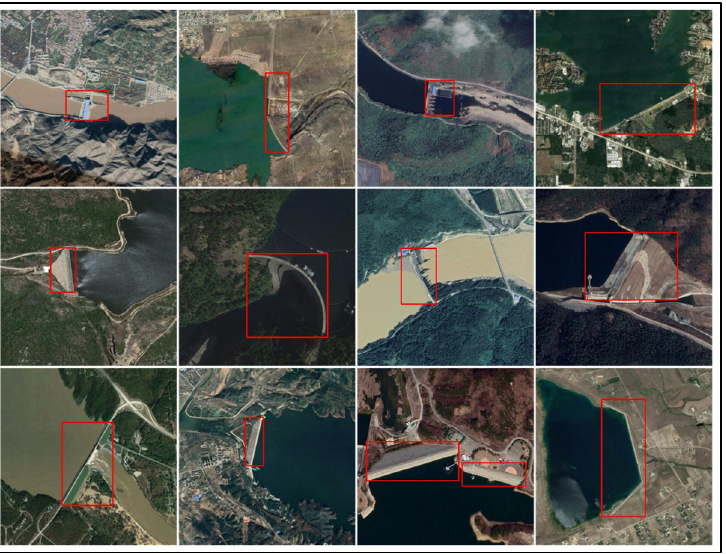
Table 1. The allocation of samples in RSDams for training, validation, and testing.